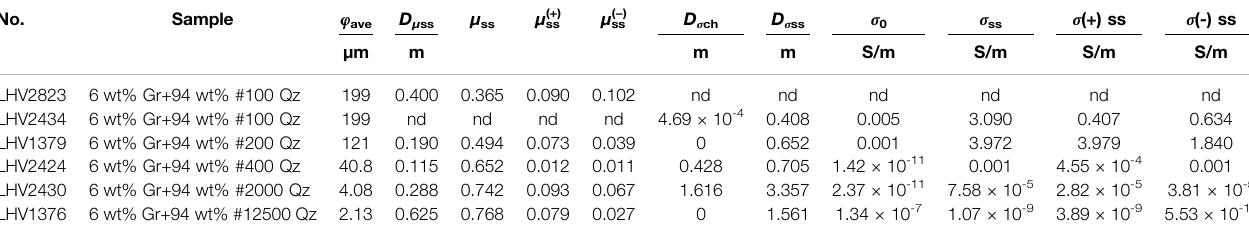
TABLE 1 | Summary of the friction conductivity parameters on synthetic Gr-bearing gouges in this study. No.